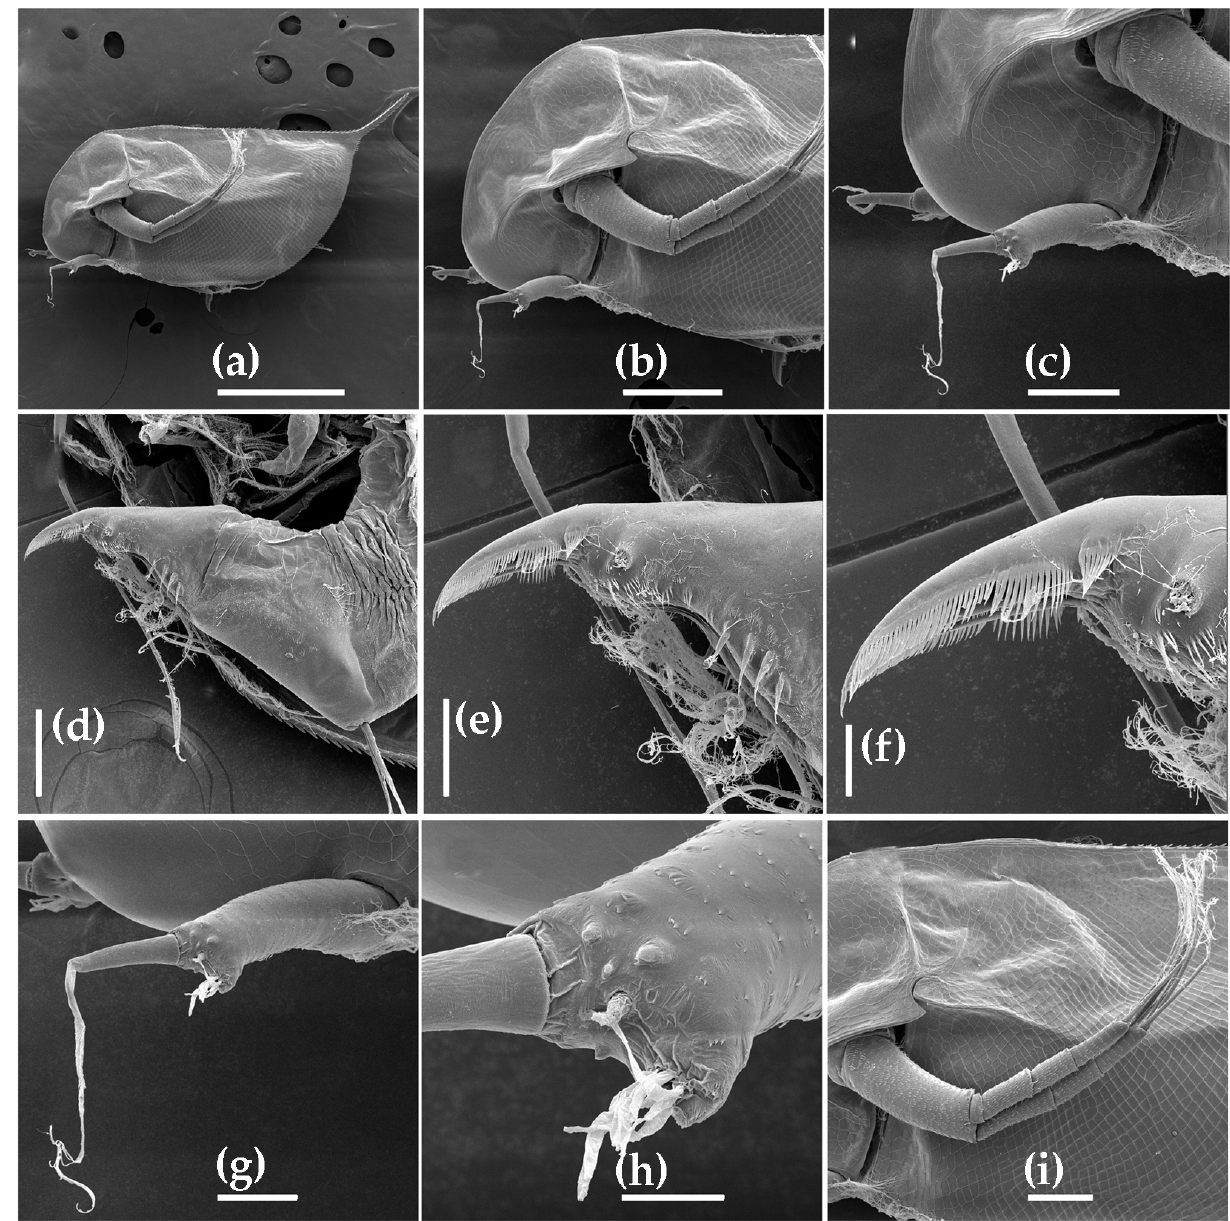
Figure 9. Daphnia arabica sp. nov., an adult male from Al Shuwaib Dam, near Al Ain city, United Arab Emirates. ( a ) Male, lateral view. ( b , c ) Head. ( d ) Postabdomen. ( e , f ) Postabdominal claws. ( g , h ) Antenna I. ( i ) Antenna II. Scale bars are 1 mm for ( a ); 0.2 mm for ( b ); 0.1 mm for ( c , d , i ); 0.05 mm for ( e , g ); 0.02 mm for ( f , h ).